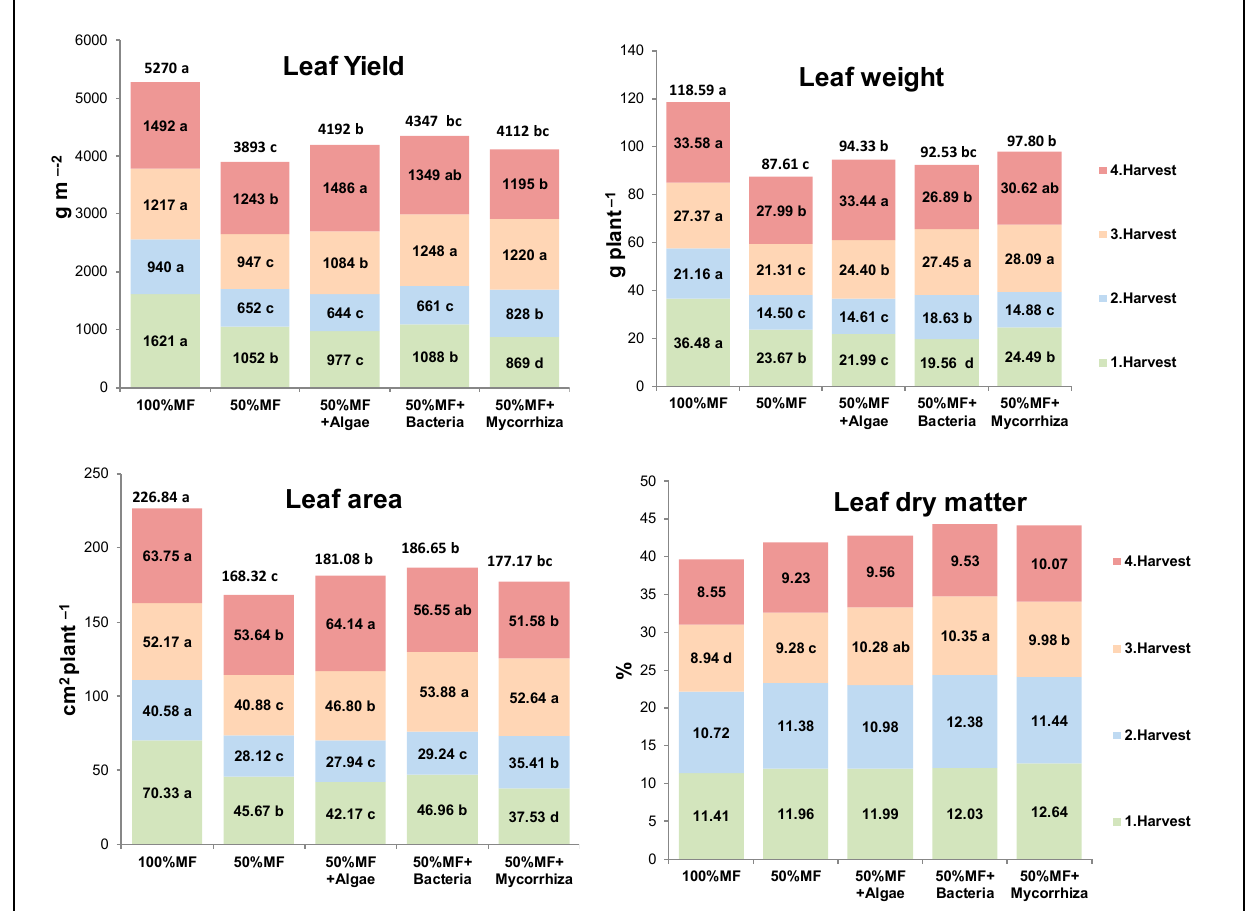
Figure 4. Effects of supplemental bio-fertilizers, under the 50% reduced mineral fertilizers, on hydroponically grown spinach baby leaf yield and components. There is no significant difference between means with the same letter in the same color histogram section.